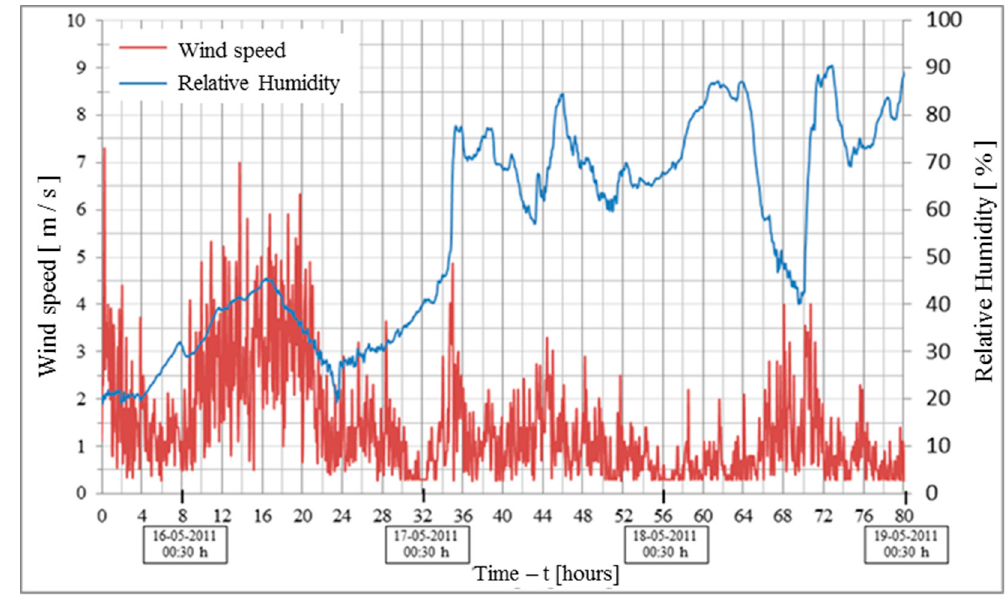
Figure 6. Monitoring of outdoor wind speed and relative humidity between 15 and 19 May 2011.